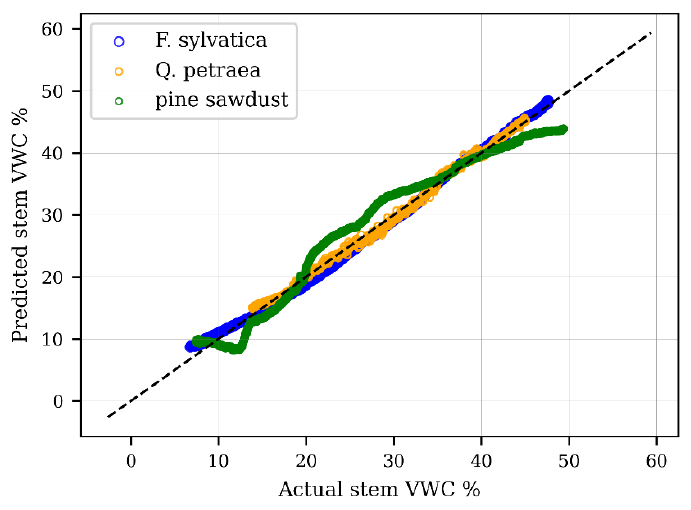
Figure 10. Predicted stem VWC values (multivariate linear regression model output) versus actual stem VWC (digital balance records) for the selected